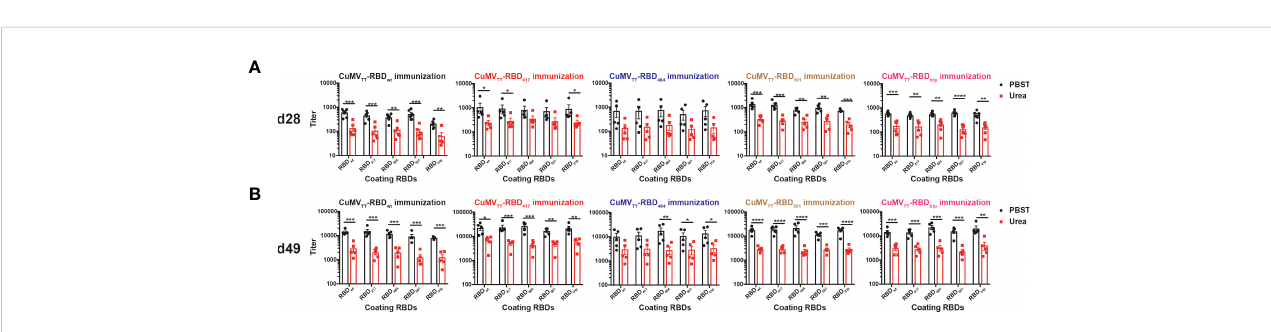
FIGURE 3 IgG antibody titers of avidity ELISA on d28 (A) and d49 (B) . Unpaired t-test was performed in Prism 9 (n=5), a =0.5 and statistical signi fi cance was displayed as p ≤ 0.05 (*), p ≤ 0.001 (**), p ≤ 0.005 (***), p ≤ 0.001 (****).